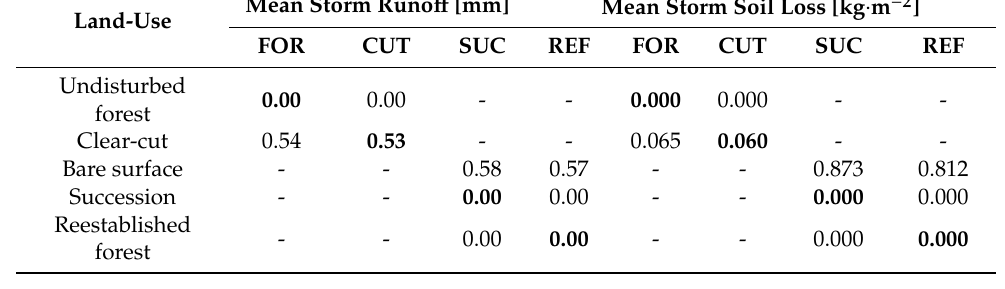
Table 15. Mean modeled storm runo ff and soil loss on standardized slope. Bold values represent current land use.